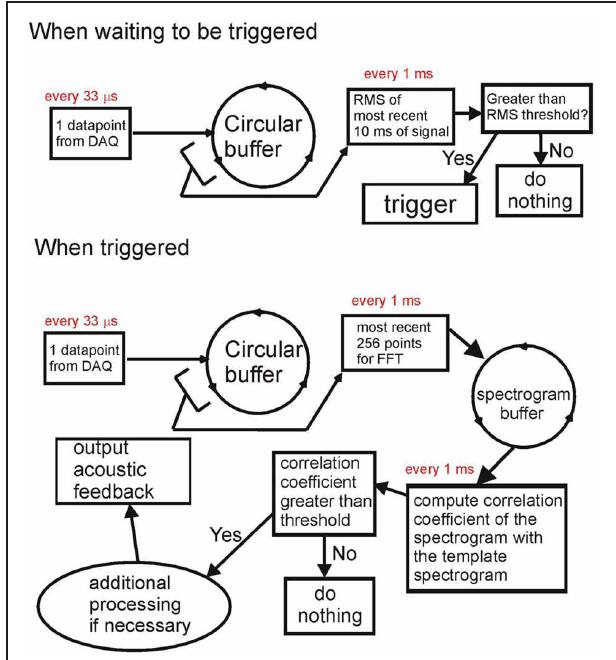
FIGURE 1 | Block diagram of the acoustic feedback system. When not triggered (top) , the system computes the rms of the input signal. When the rms exceeds the threshold, the system is triggered. When triggered (bottom) , the system computes the spectrogram of the most recent 20ms of signal and computes the correlation coefficient of this spectrogram with the spectrogram of the template sound (e.g., song syllable). The template sound is detected when the correlation coefficient exceeds a threshold value; in this case, acoustic feedback can be generated. Both the input and the acoustic output are saved to the computer hard